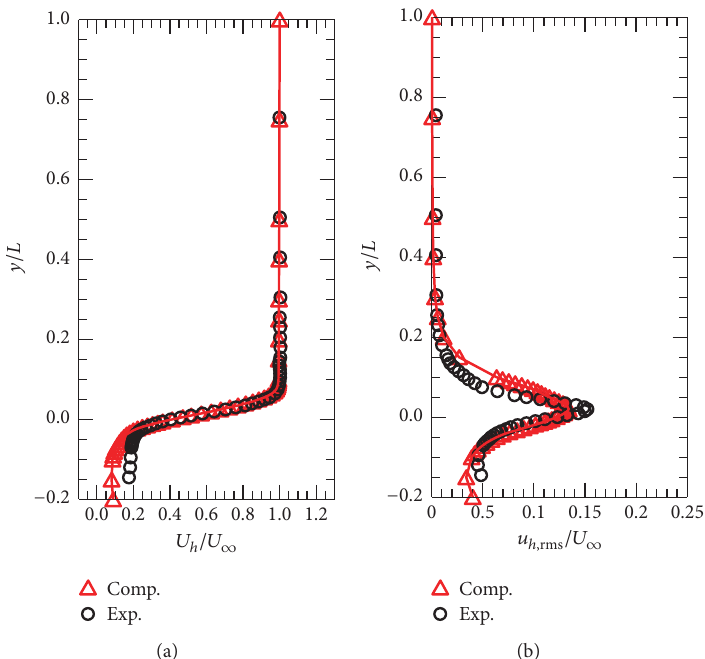
Figure 7: Predicted and measured profiles of mean velocity (a) and turbulent intensity (b) for the cavity flow with 𝐷/𝐿 = 0.5 .